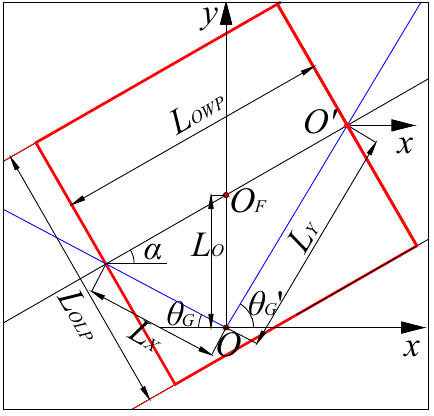
Fig. 10 Projection of the support opening on the vertical